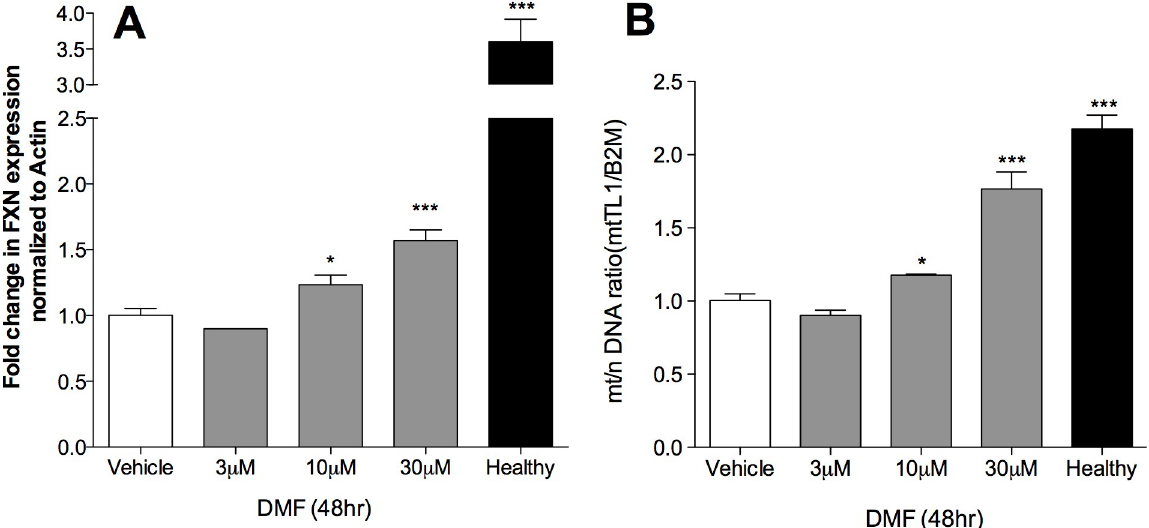
Fig 5. DMF increases FXN expression and mitochondrial biogenesis in 48 hr treated patient derived fibroblast cells. Cells were treated with 0.01% DMSO vehicle, 1,3,10 or 30 μ M DMF for 48 hr (A) Frataxin mRNA expression measured by qPCR as FXN normalized to Actin. Vehicle, n = 8; 3 μ M, n = 1; 10 μ M, n = 4; 30 μ M, n = 8; Healthy, n = 3. (B) Mitochondrial DNA copy number was measured by q-PCR analysis as ratio of mitochondrial DNA over nuclear DNA; mt-TL1/B2M. Vehicle, n = 9; 3 μ M, n = 3; 10 μ M, n = 5; 30 μ M, n = 9; Healthy, n = 3. Bars represent averages ± standard deviations (p < 0.05 � , p < 0.01 �� , p < 0.001 ���